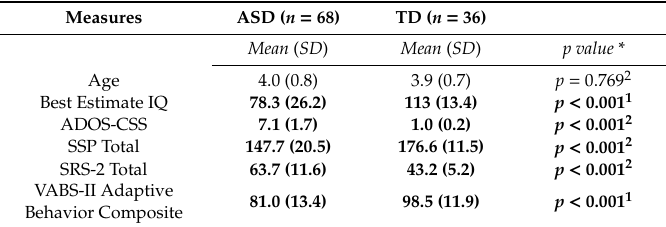
Table 1. Description of the ASD and TD